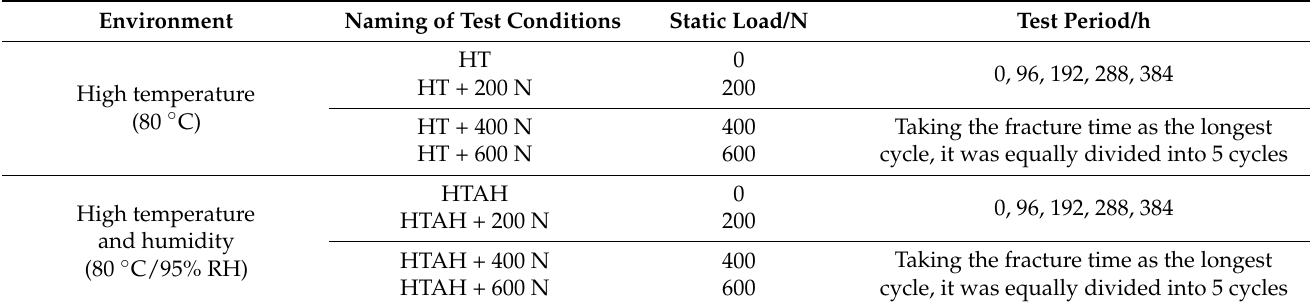
Table 3. Testing program.